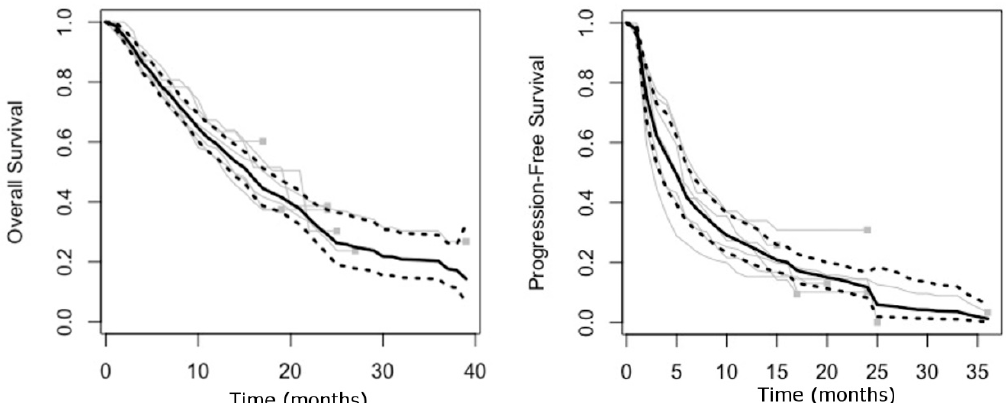
Figure 1. Pooled reconstructed survival curves for overall survival (OS) and progression-free survival (PFS) from clinical trials assessing immune-checkpoint inhibitors (ICIs) in advanced hepatocellular carcinoma (HCC). Black lines represent pooled reconstructed survival curves; dotted lines represent lower and upper 95% confidence interval; gray lines represent reconstructed survival curves of single trial arms.